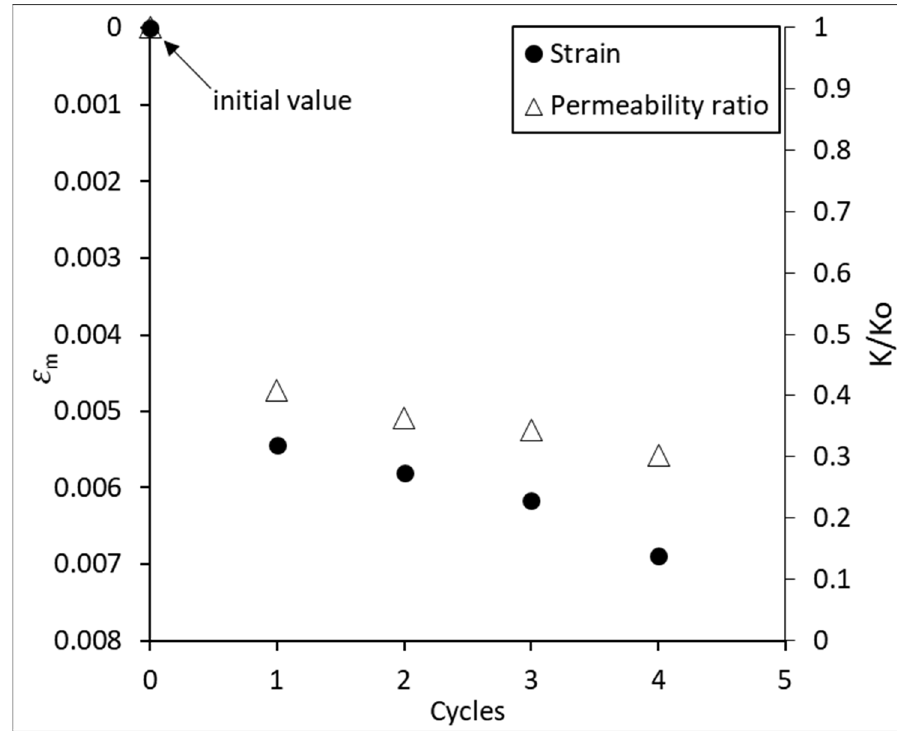
Figure 8. Unrecoverable strain and permeability increase with stress cycles (coal sample 4).